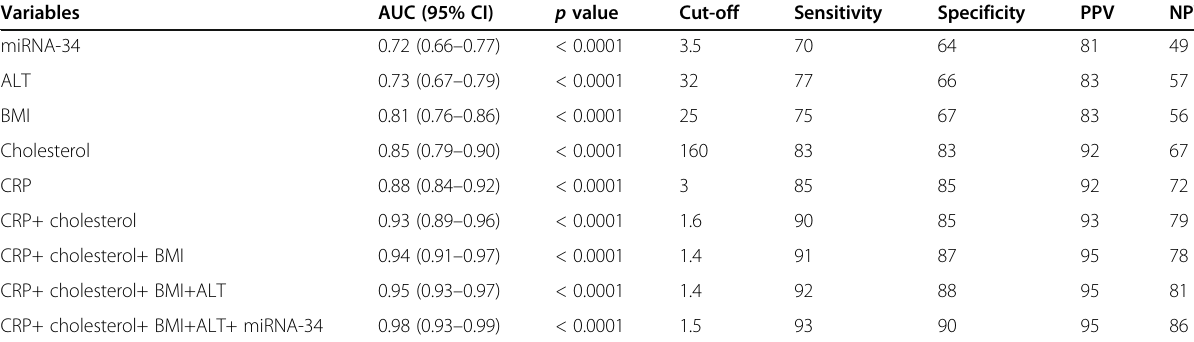
Table 2 Diagnostic power of single and combined candidate markers (CRP, cholesterol, BMI, ALT, and miRNA34) to diagnose NAFLD Variables